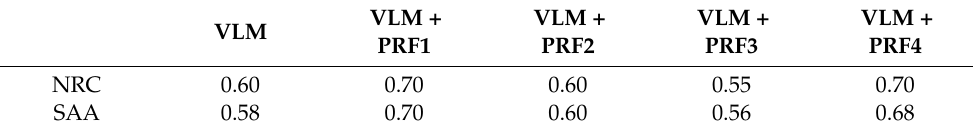
Table 6. ASTM C423 results.